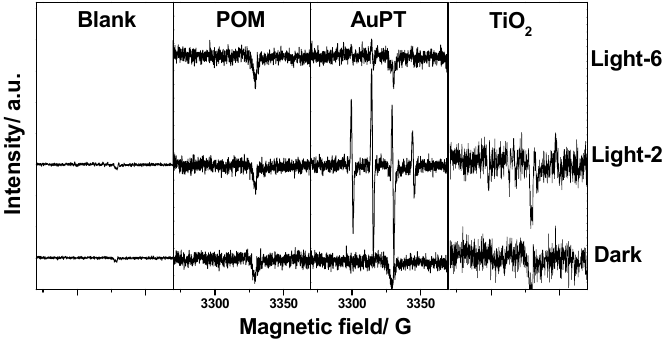
Figure 7. ESR spectra of active oxygen species generated in the in situ photocatalytic reaction with different catalysts. The reaction without photocatalyst: “Blank”. The reaction without light irradiation: “Dark”. The reaction after irradiating for 2 min:“Light-2”; similarly, 4 min: “Light-4”.